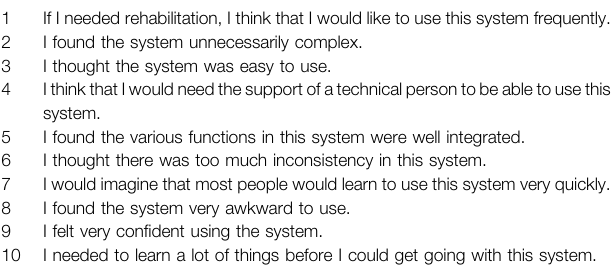
TABLE2| TheSystemUsabilityScale(SUS)questionnaire(Brooke,1996)usedto evaluate the usability of the system.